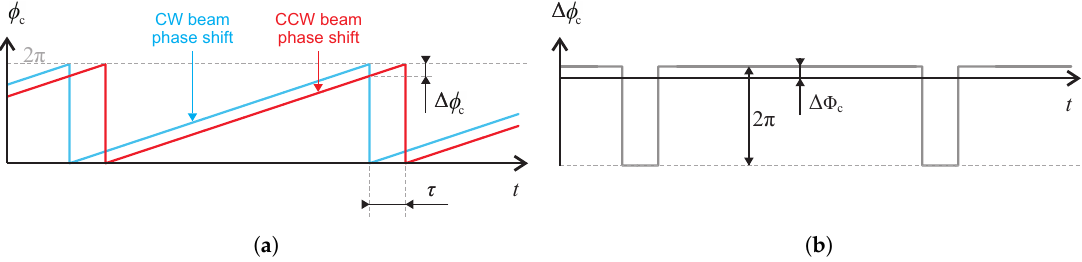
Figure 1. The common compensation with sawtooth modulation: the phase shift introduced to the CW and CCW beams ( a ), and their resulting phase difference ( b